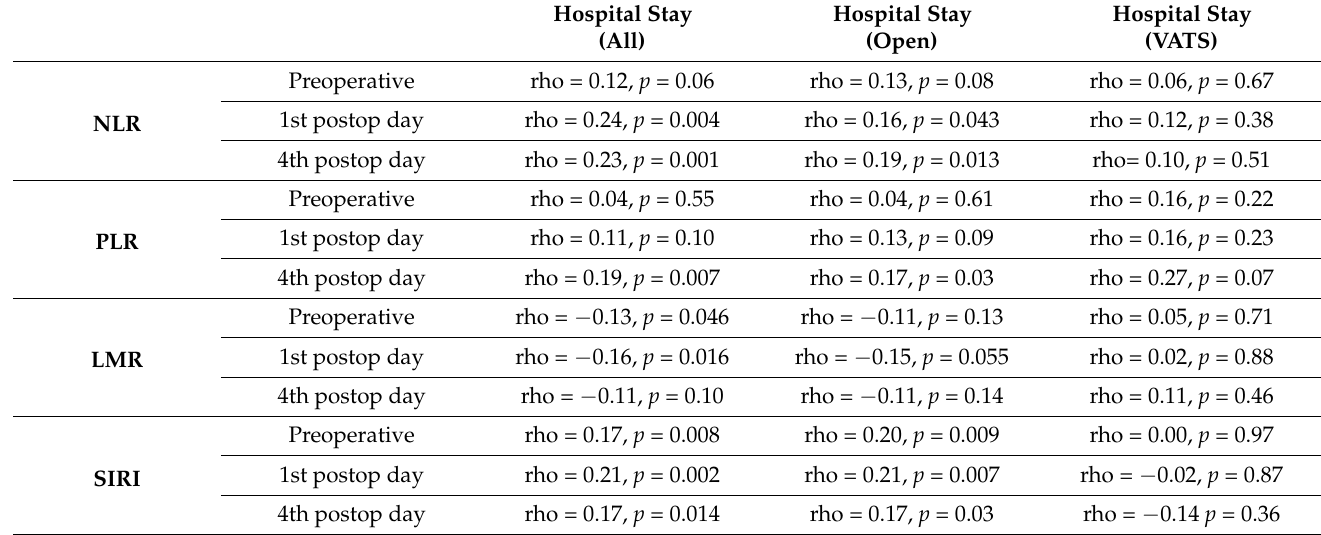
Table 3. Blood cell count indexes and hospital stay in the global cohort and the open and VATS surgery groups.